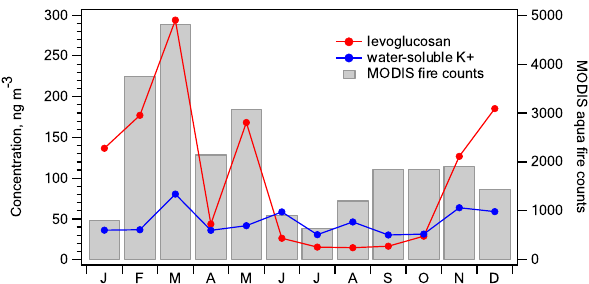
Fig. 7. Monthly mean levoglucosan and water-soluble potassium concentrations from all sites compared with monthly mean MODIS Aqua fire counts from seven states in the southeastern US.